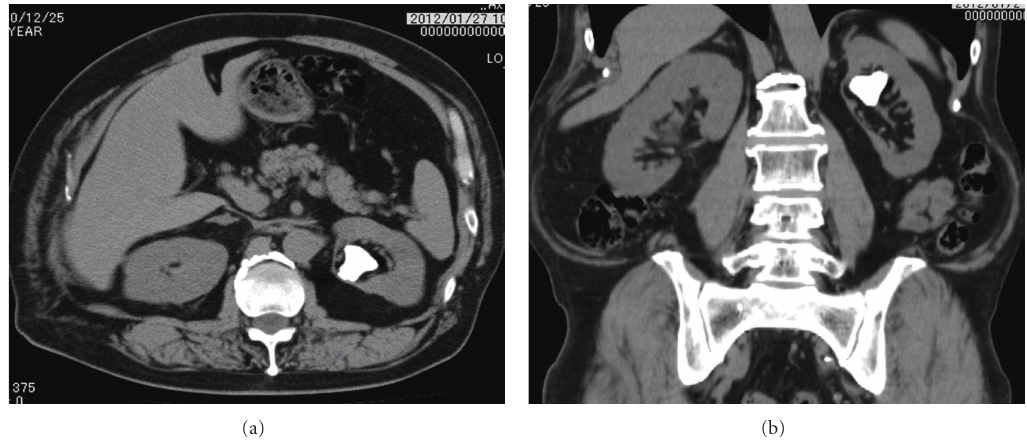
Figure 1: Preoperative axial (a) and coronal (b) noncontract CTKUB films.